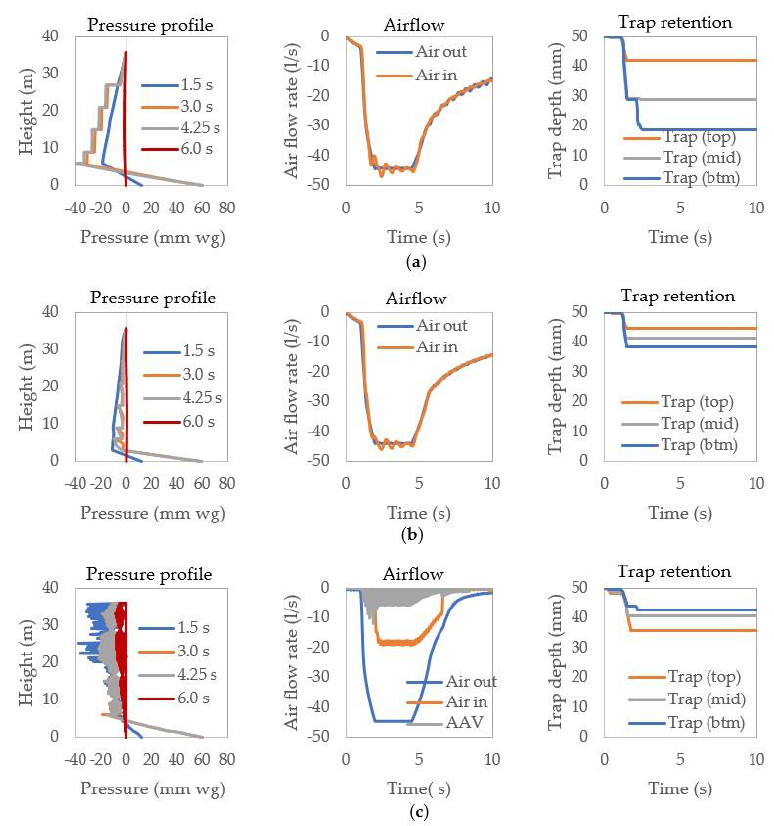
Figure 7. Simulated elements of operational performance, including the stack pressure profile, airflow, and resultant trap retention depth for the 10 story building with 100 mm diameter stack in system configurations: ( a ) single-stack; ( b ) fully‐ vented; and ( c ) single-stack with AAVs.